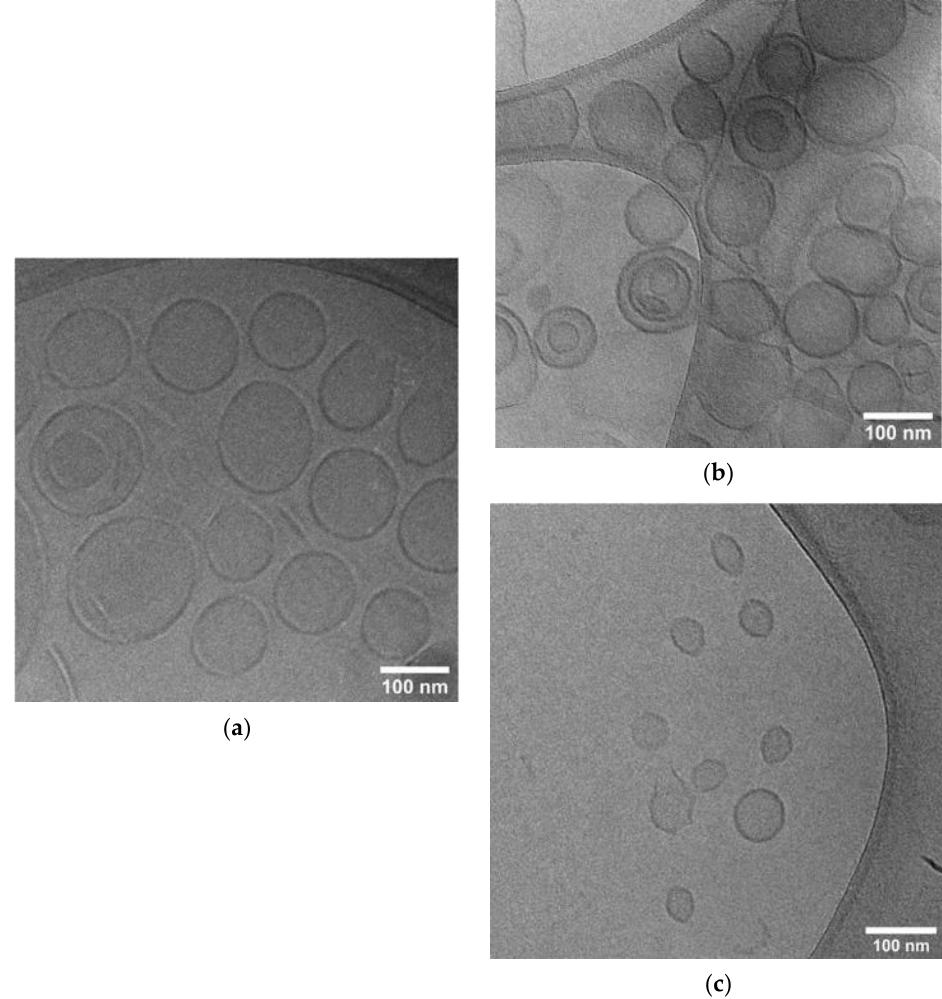
Figure 1. Cryo-TEM images of different liposomal formulations of AmB: ( a ) PEGylated liposomal formulation; ( b ) conventional liposomal formulation; ( c ) AmBisome ® .